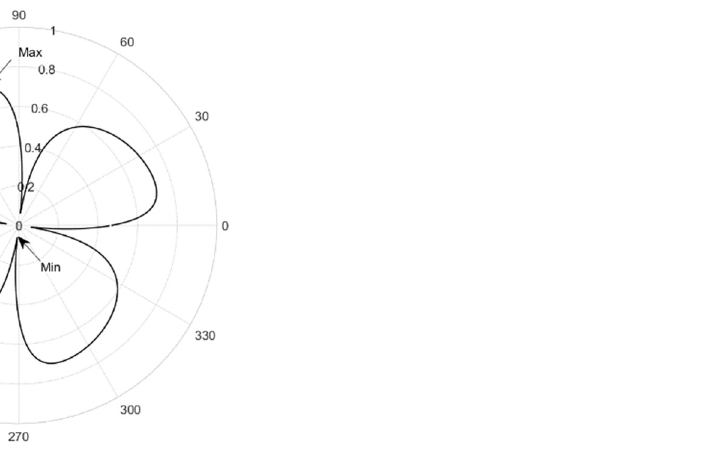
Figure 2. Polarization coherence pattern, Mean represents the average value of the RPC feature, Max represents the maximum value of the RPC feature, and Min represents the minimum value of the RPC feature. Table 4. Features of RPC.